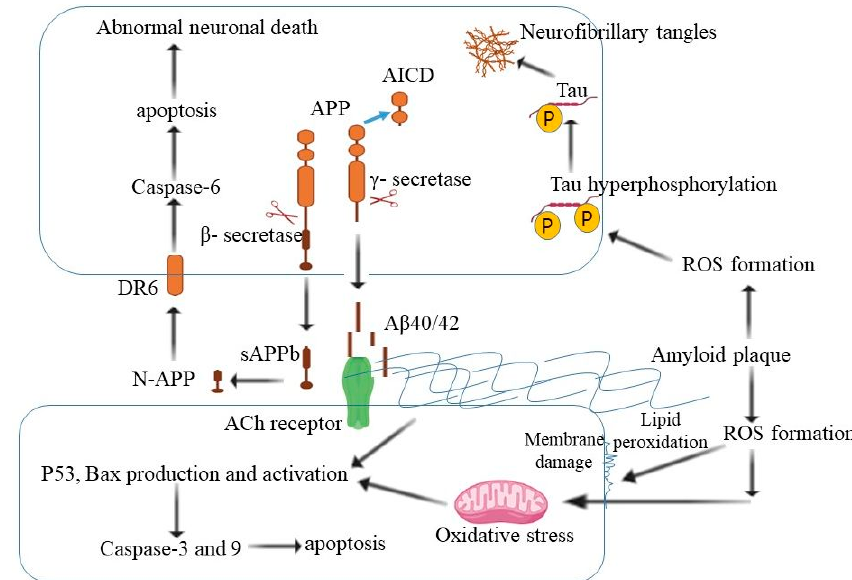
Figure 2. The molecular mechanism of β - and γ -secretase for the processing of APP. The extracellular amyloid deposits are the primary cause of AD. The natural compounds may be alternative agents that have β - and γ -secretase inhibition for the management of AD (APP—amyloid precursor protein, AICD—APP intracellular domain, A β — β -amyloid, ROS—reactive oxygen species). 5. Inhibition of Monoamine Oxidase Activity Using Natural Compounds Monoamine oxidases (MAOs) are flavoproteins that catalyze the oxidative deamina- tion of biogenic and xenobiotic amines in the outer mitochondrial membrane. There are